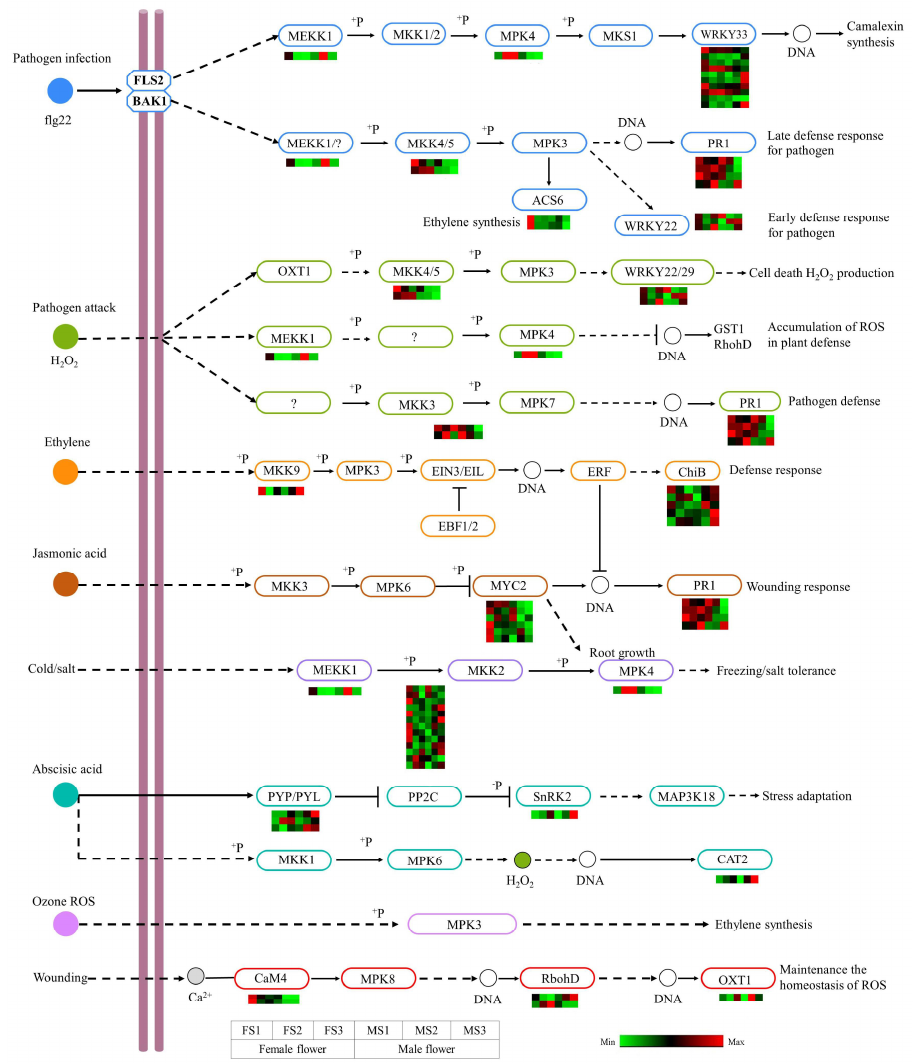
Figure 8. Analysis of DEGs related to the MAPK signaling pathway. The color scale from Min (green) to Max (red) refer to the expression value from low to high. ROS, reactive oxygen species.